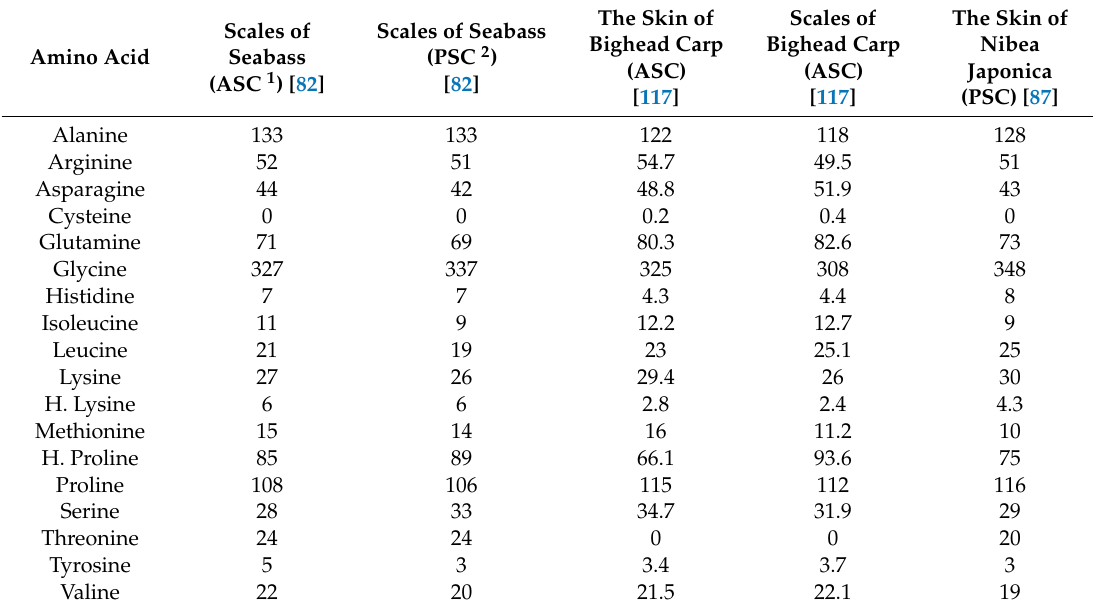
Table 6. Amino acid distributions of collagen samples obtained from several fish species using di ff erent extraction